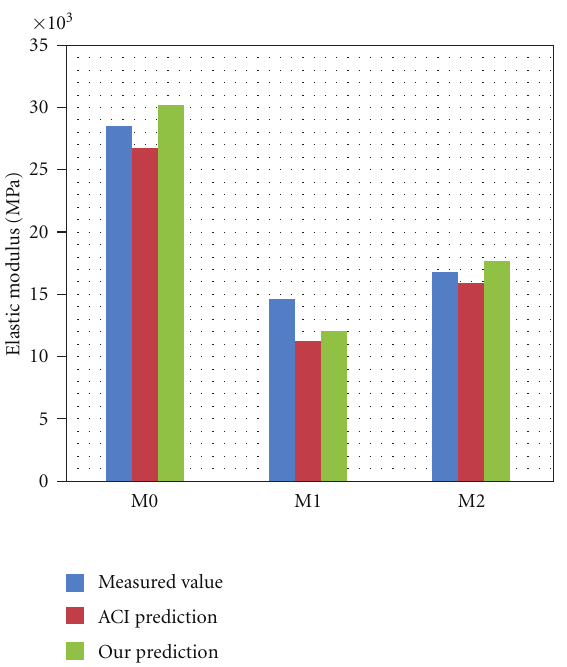
Figure 7: Predicted results versus actual results using (4) and (5).